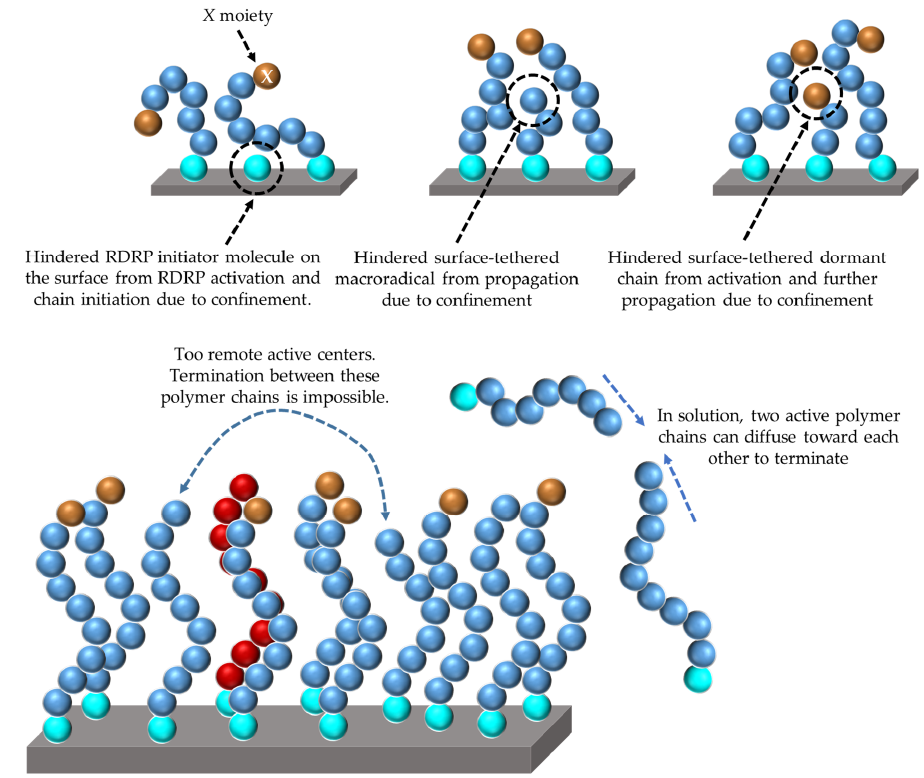
Figure 2. Visualization of confinement in surface initiation—reversible deactivation radical polymerization (SI-RDRP), leading to different reaction probabilities for reactions on the surface and in the solution. For illustration purposes, emphasis is on chain initiation, propagation, and activation/deactivation at the top and termination at the bottom. Here, RDRP initiator molecules are represented as cyan spheres, monomer units either in dormant or active polymer chains are represented as blue spheres, and monomer units in dead polymer chains are represented as red spheres. In addition, the “X” chain-ends of dormant polymer chains are depicted as brown spheres to differentiate themselves from the active species.